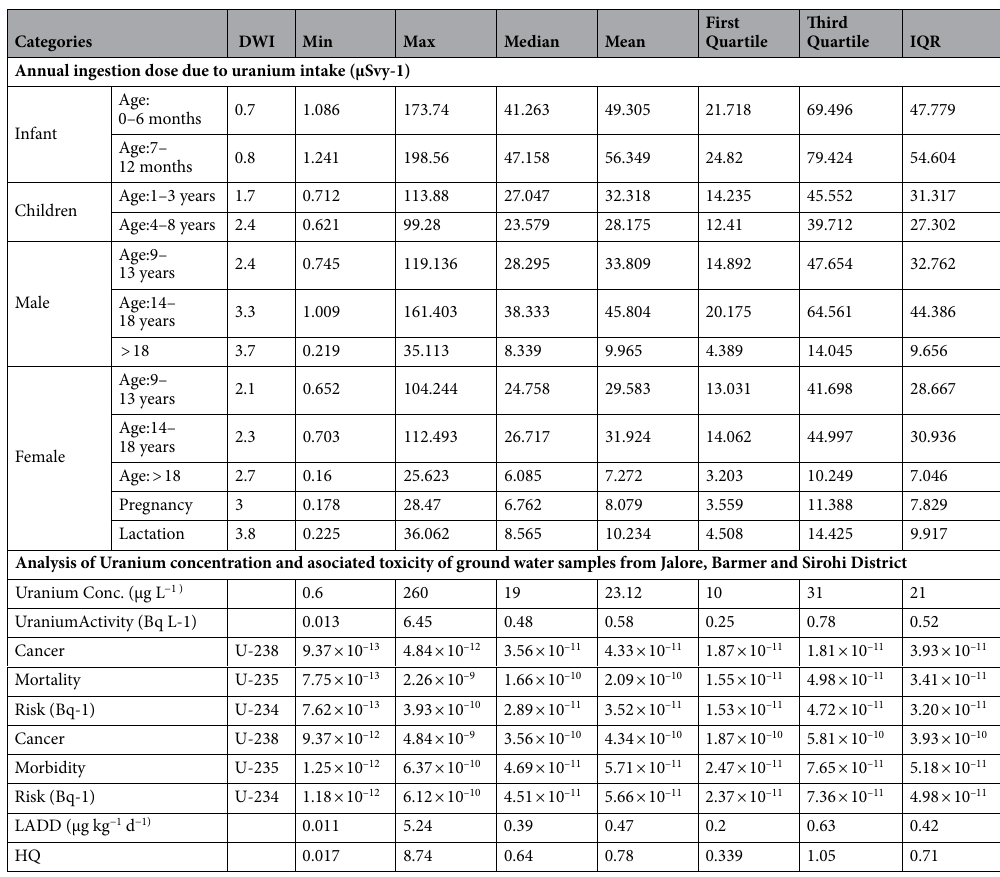
Table 2. Radiotoxicity and chemical toxicity due to U (here U-238, U-235 and U-234 are isotopes of Uranium) in groundwater (DWI = Daily water intake).